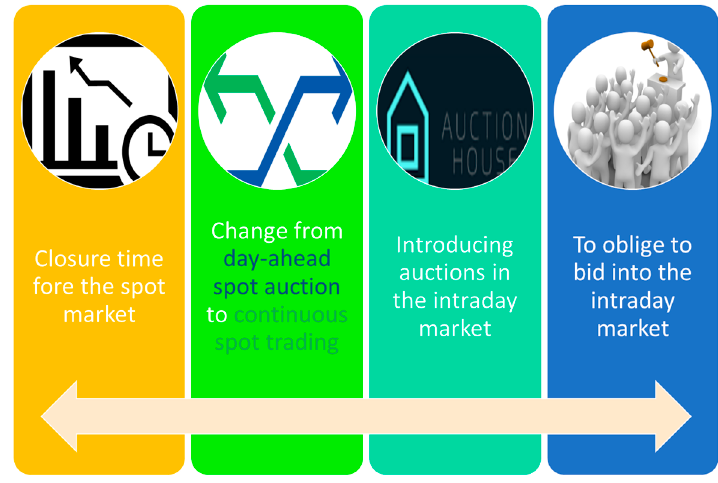
Figure 5. Classification for improving the functioning of the intraday market.